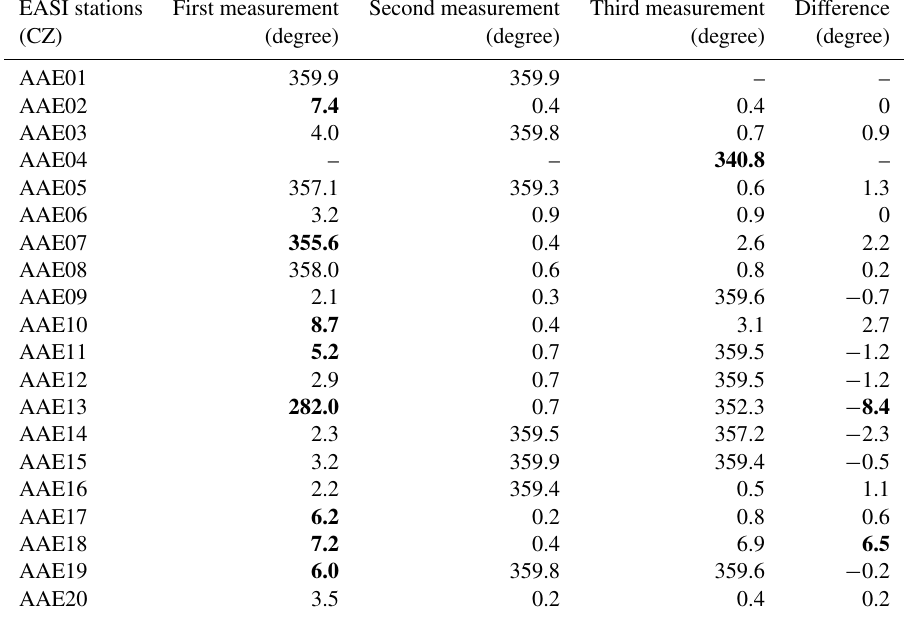
Table 2. Sensor orientation during the AlpArray-EASI complementary experiment measured by gyrocompass. The largest differences are in